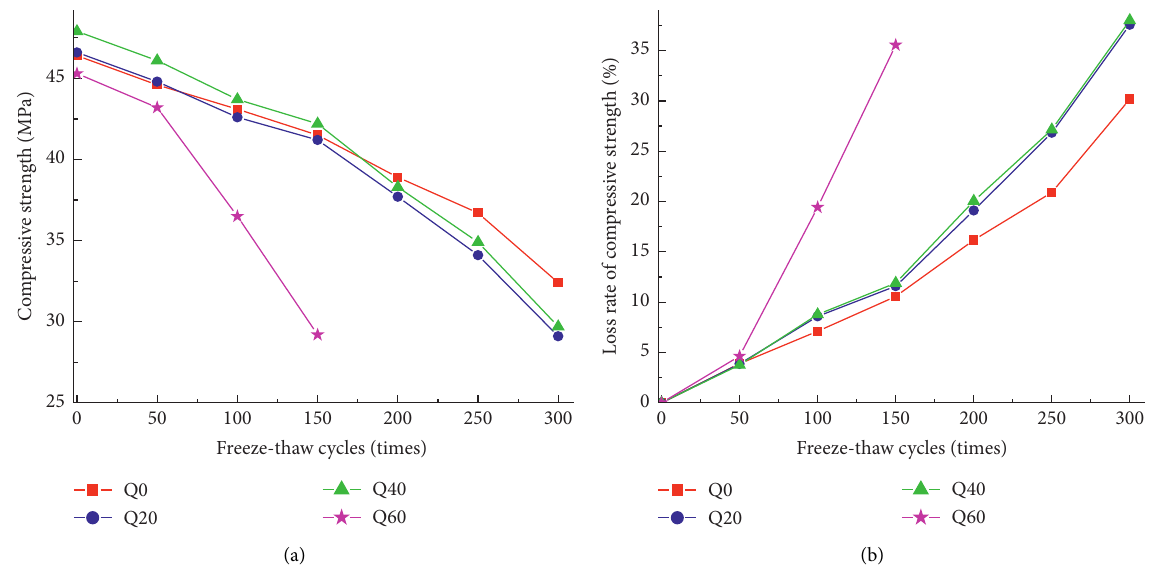
Figure 5: (a) Compressive strength. (b) Loss rate of compressive